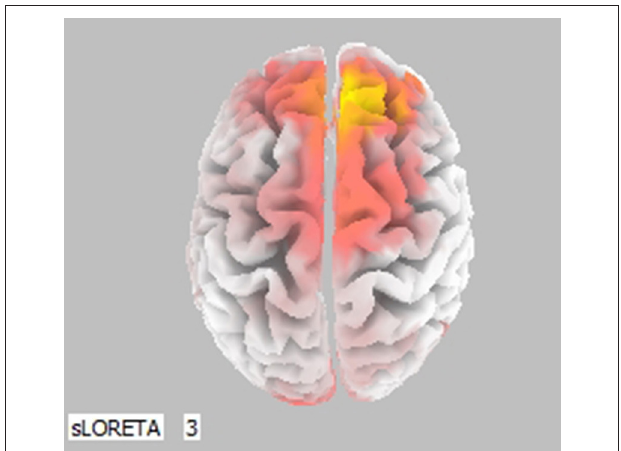
FIGURE 9 | Statistical significant cerebral activity was estimated by LORETA software in the Lower Alpha Band comparing two pieces of information presented in (0,BP + SN) with (0, SN + BP). A similar result was generated in the Upper Alpha Band. Orange areas suggests a significant increase in cortical activity for the first scenario (0, BP + SN).